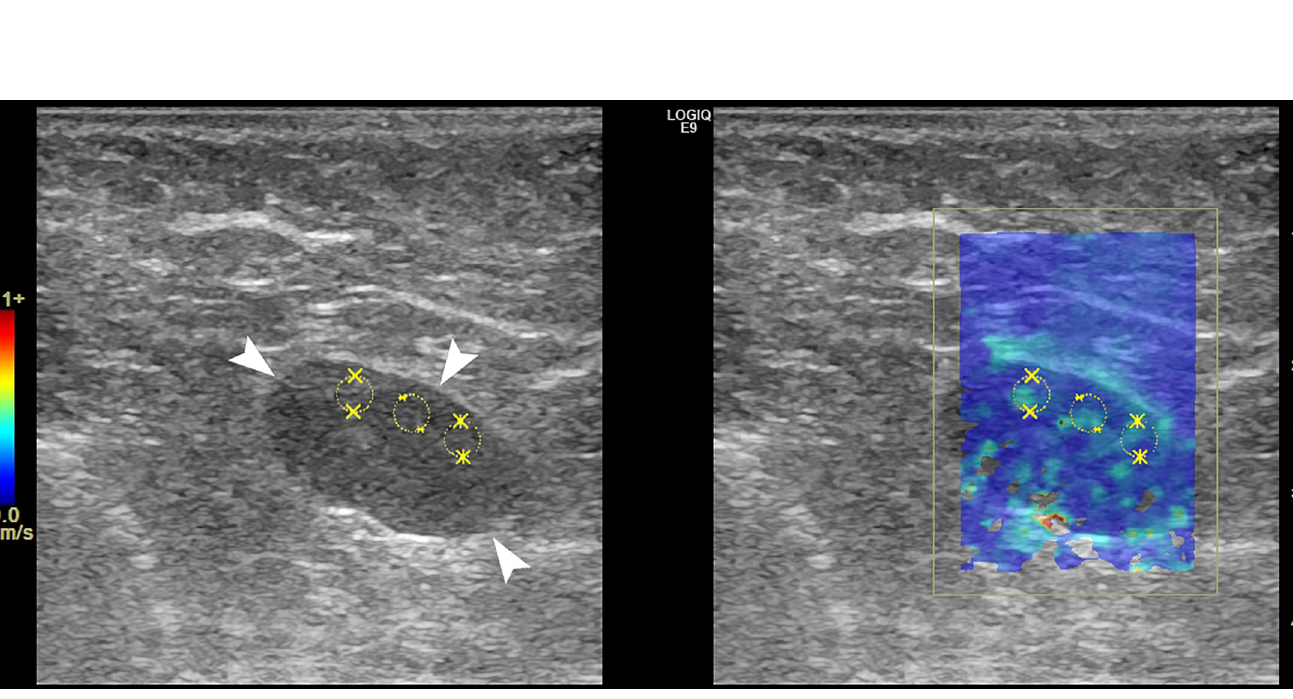
PLOS ONE | https://doi.org/10.1371/journal.pone.0226994 January 13,